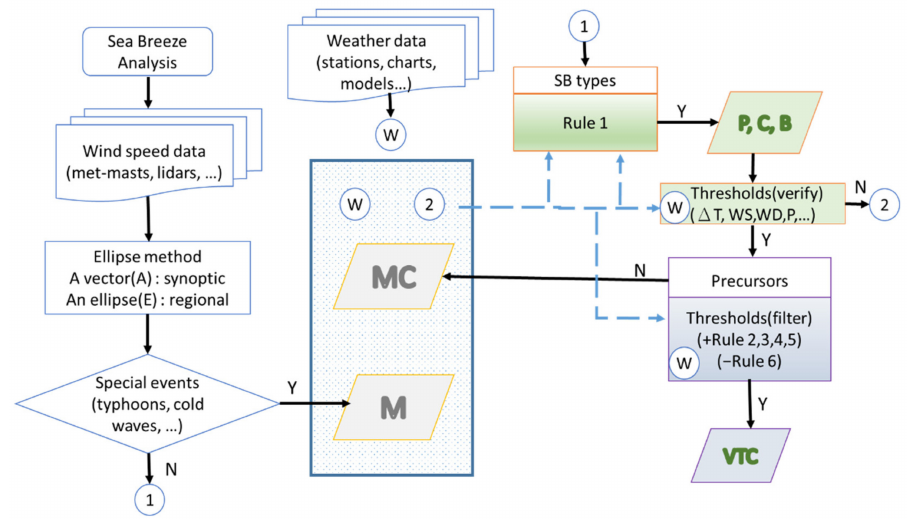
Figure 18. The flow chart of the EACH method. P,C,B denotes pure, corkscrew, and backdoor sea breeze, respectively. VTC denotes vertices which are points that wind speed trend change in time series. M and MC denote manual processes required for processing data. The blue circle with W inside denotes weather